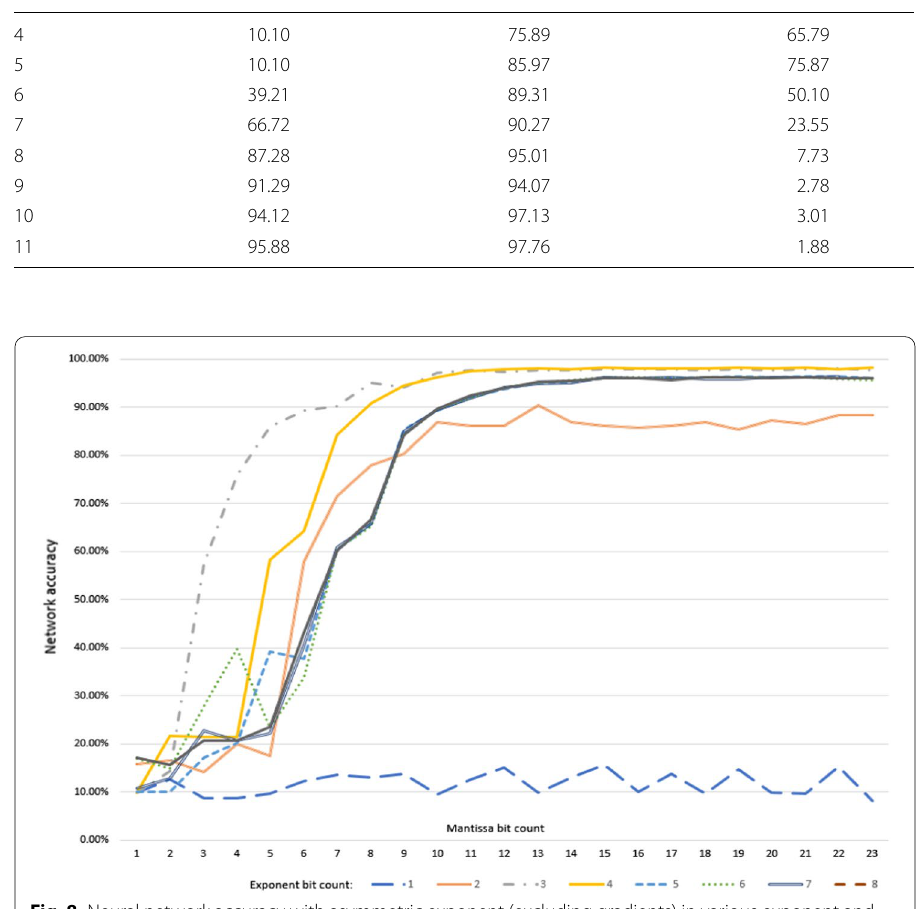
Fig. 8 Neural network accuracy with asymmetric exponent (excluding gradients) in various exponent and mantissa bit count